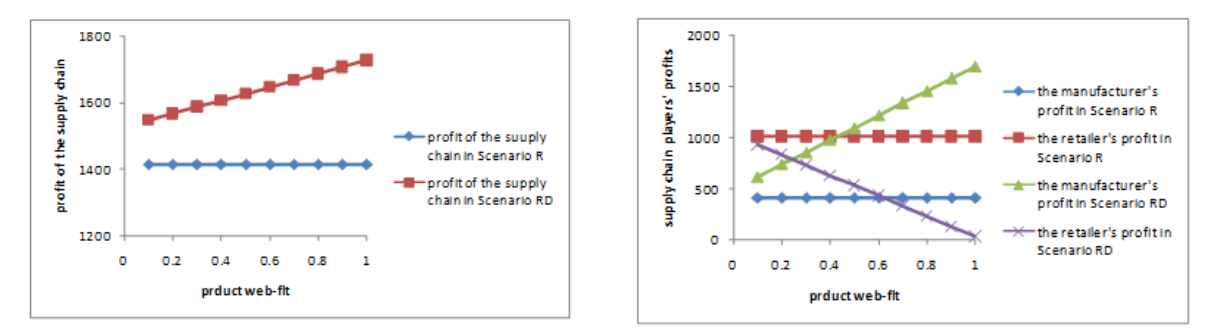
Figure 2. Profit of the supply chain under different scenarios